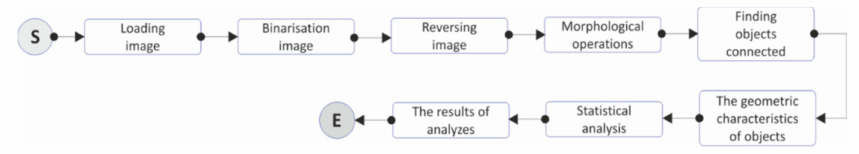
Figure 5. Elaborated algorithm of an evaluation of graphic images (pictures) of WPCs